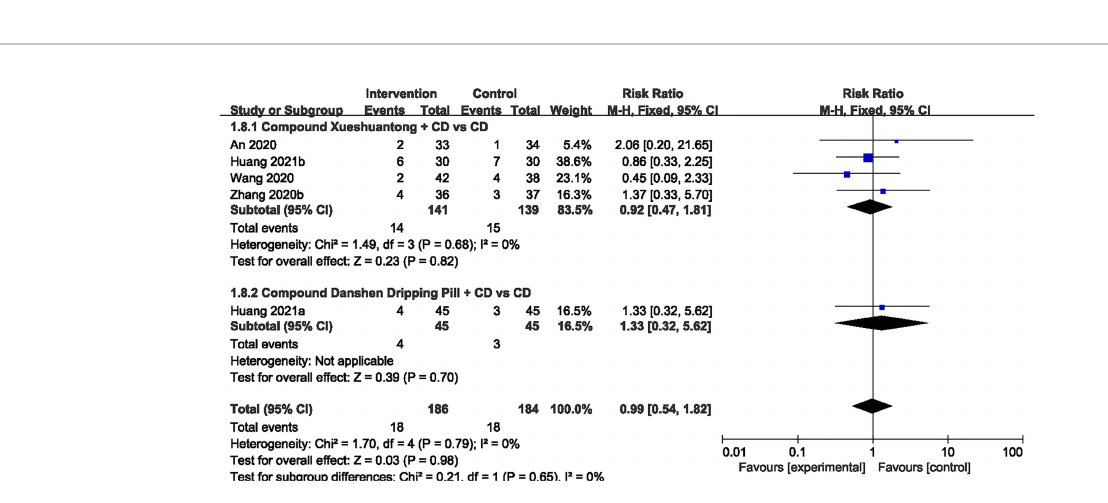
FIGURE 8 | Forest plots of comparison of adverse events for CPMs plus CD versus CD alone.